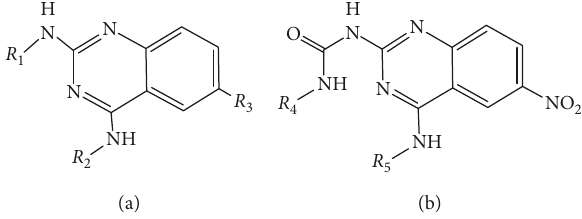
Scheme 1: Quinazoline derivatives as potential Pin1 inhibitors core structures for molecules (a) 1–10 and (b) 11–17.